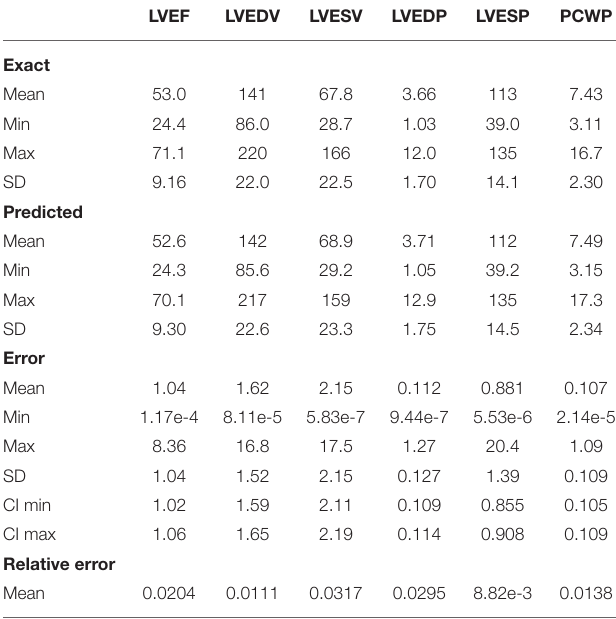
TABLE 2 | Results of 0D simulations using exact and predicted parameters of the test set.